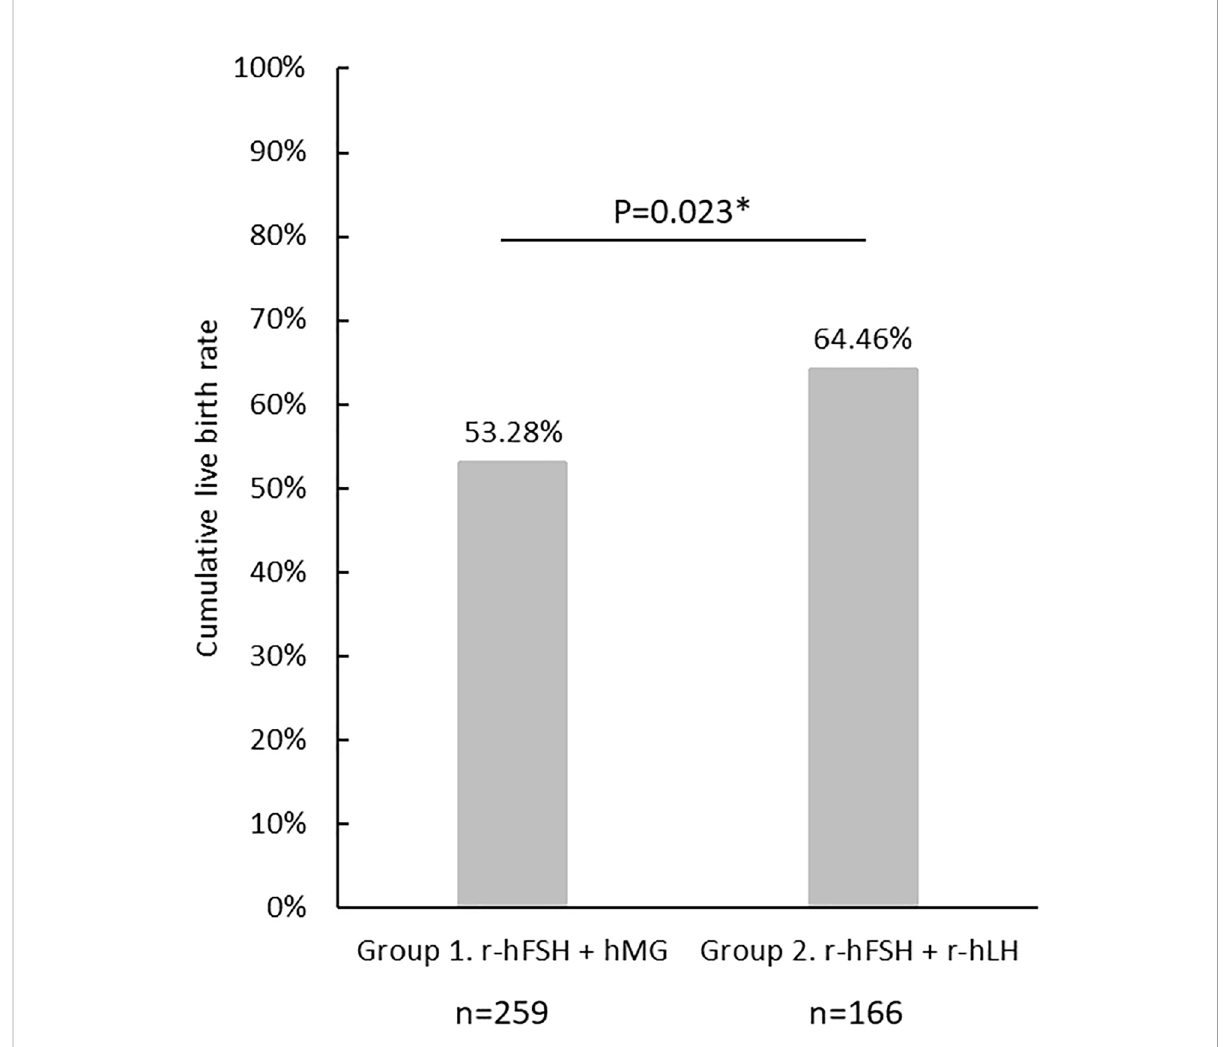
FIGURE 2 The cumulative live birth rate in Group 1(r-hFSH+hMG) and Group 2 (r-hFSH+r-hLH). *represents statistical signi fi cance